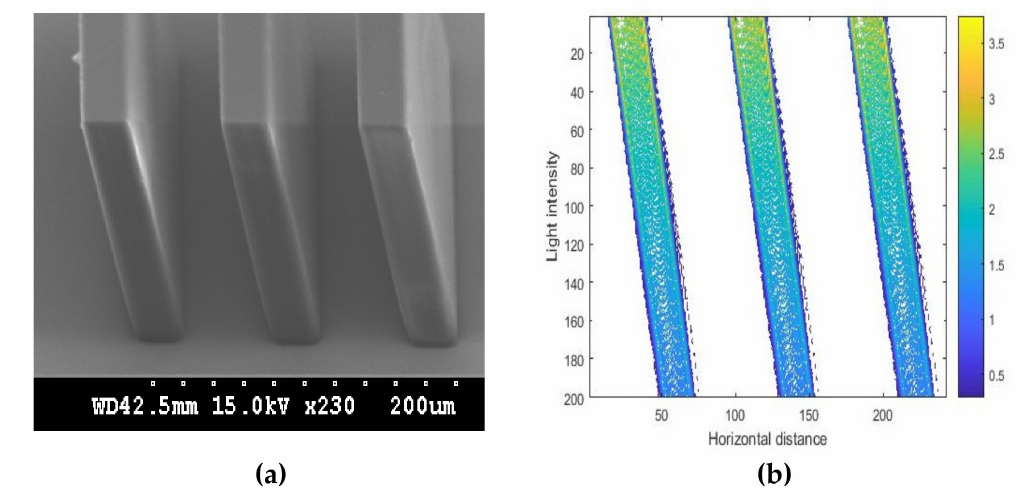
Figure 20. SEM photo of an oblique SU-8 pillar ( a ) and simulation result ( b ) for incident angle of 30 ◦